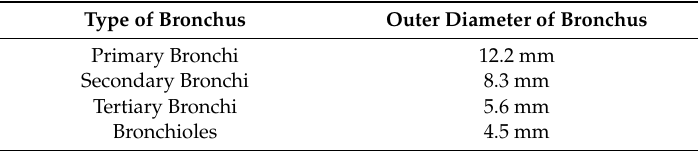
Table 3. Typical diameter of bronchus [37].